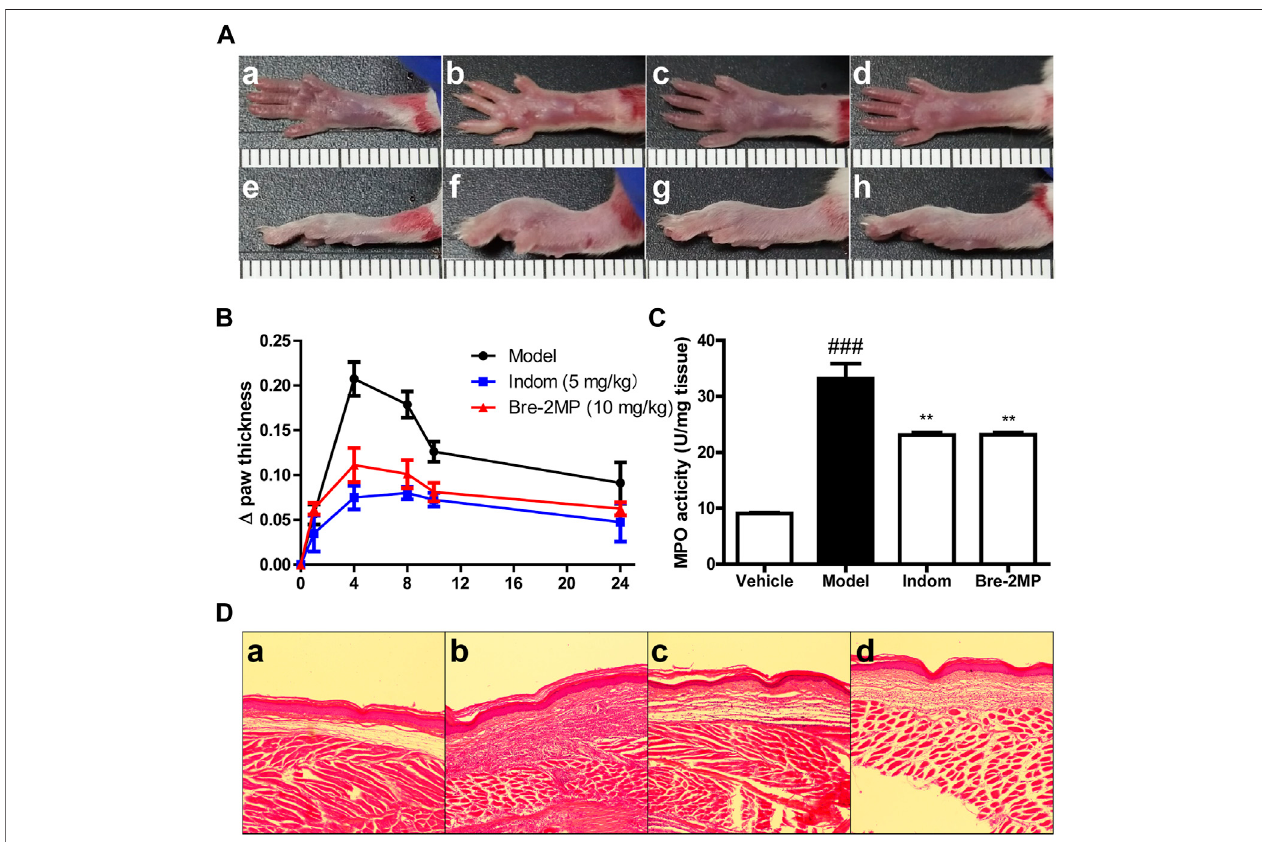
FIGURE 6 | Inhibition of in fl ammatory response by brevinin-2MP in carrageenan-induced paw. A total of 50 μ l of 1% carrageenan in the absence or presence of 10 mg/kg brevinin-2MP and 5 mg/kg indomethacin was injected into the mice paws before paw swelling; myeloperoxidase (MPO) activities and histological measurement were performed as well. (A) Mice paw photographs at 4 h post-injection. The labels a – d and e – h refer to the bottom and lateral views of the paws, respectively.aande:pawsfromsalinecontrolgroup;bandf:pawsfromcarrageenanplussalinegroup;candg:pawsfromcarrageenanplusindomethacingroup; d and h: paws from carrageenan plus brevinin-2MP group. The scale unit shown in the images is centimeter. (B) Paw swelling volume at different time points after carrageenan administration. (C) MPO activity in the paws. Columns from left to right represent the MPO activity in the mice paws from the groups treated with saline, carrageenan plus saline, carrageenan plus indomethacin, and carrageenan plus brevinin-2MP, respectively. (D) HE staining of the mice paws at 4 h post-injection. The labels a – d refer to images from mice paws treated with saline, carrageenan plus saline, carrageenan plus indomethacin, and carrageenan plus brevinin-2MP, respectively. The scale bars were 50 μ m. Thestatistical results are mean ± SEM ( n (cid:1) 6). ** p < 0.01: signi fi cantdifferencein comparison with thecontrol uniquely injected with carrageenan. ### p < 0.001: signi fi cant difference with the control without the injection of brevinin-2MP and carrageenan.